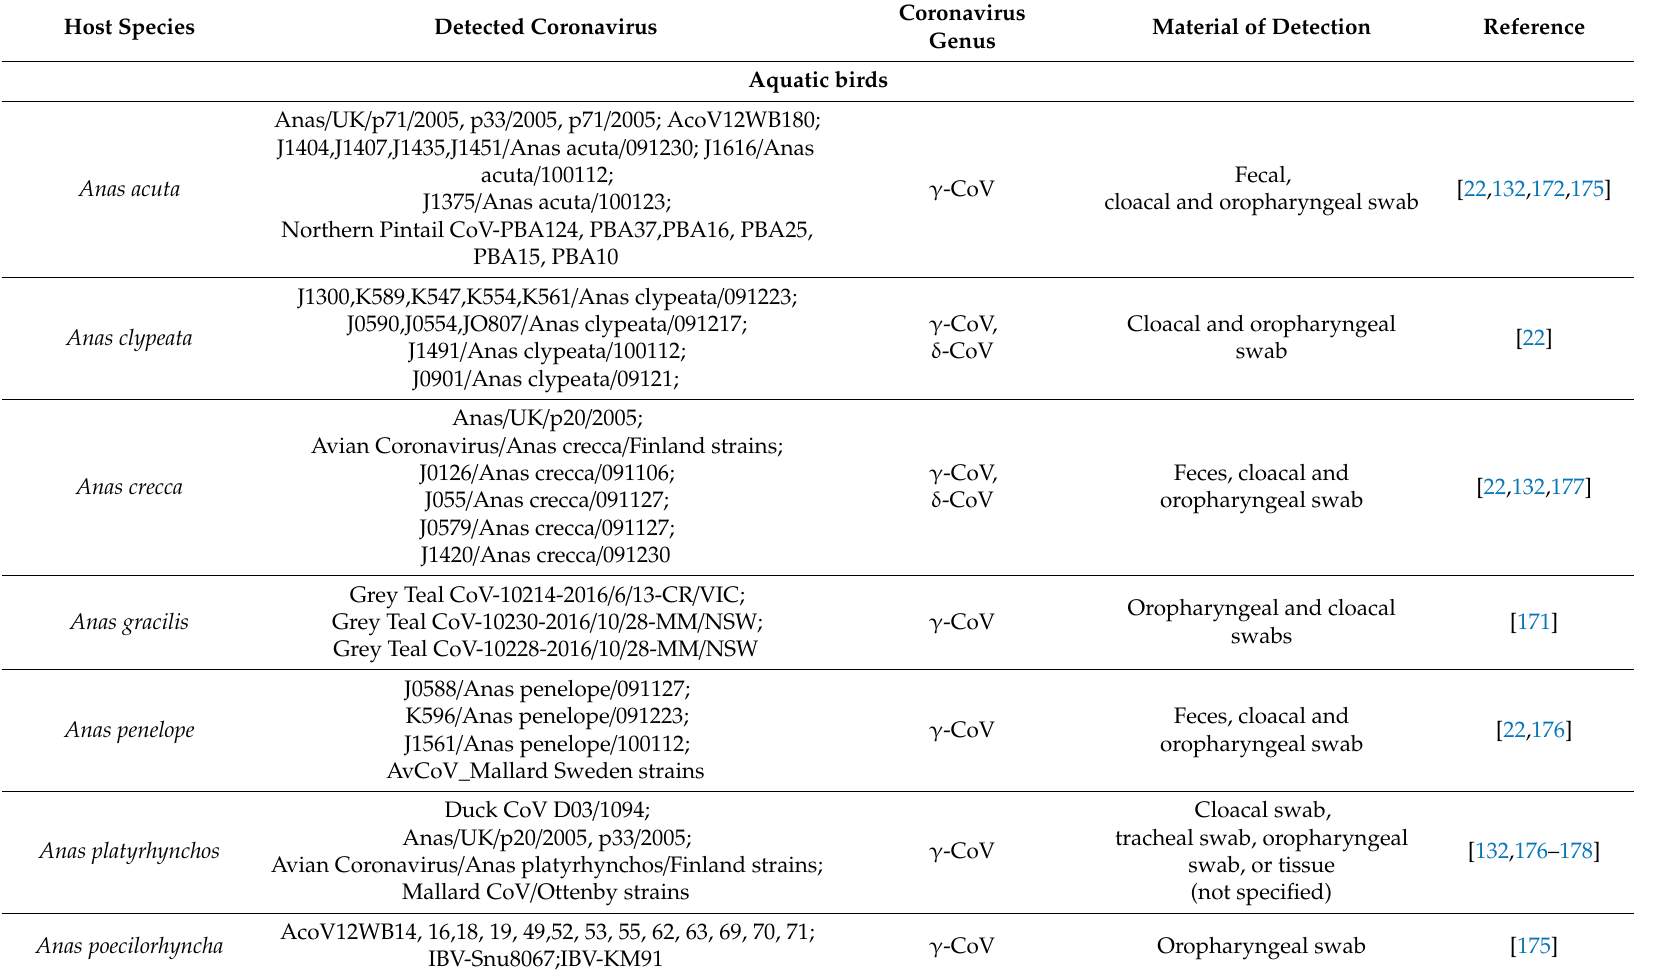
Table 1. Summary of confirmed associations of coronaviruses with aquatic